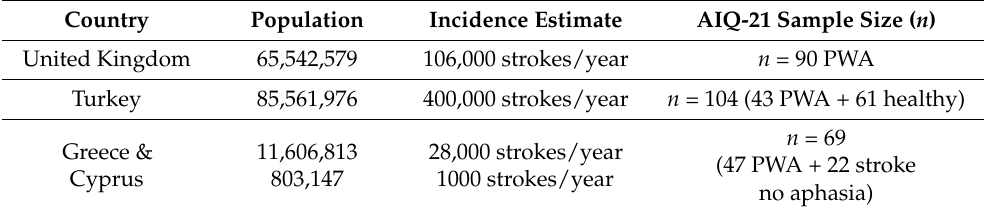
Table 1. Sample size of the AIQ-21-GR based on former